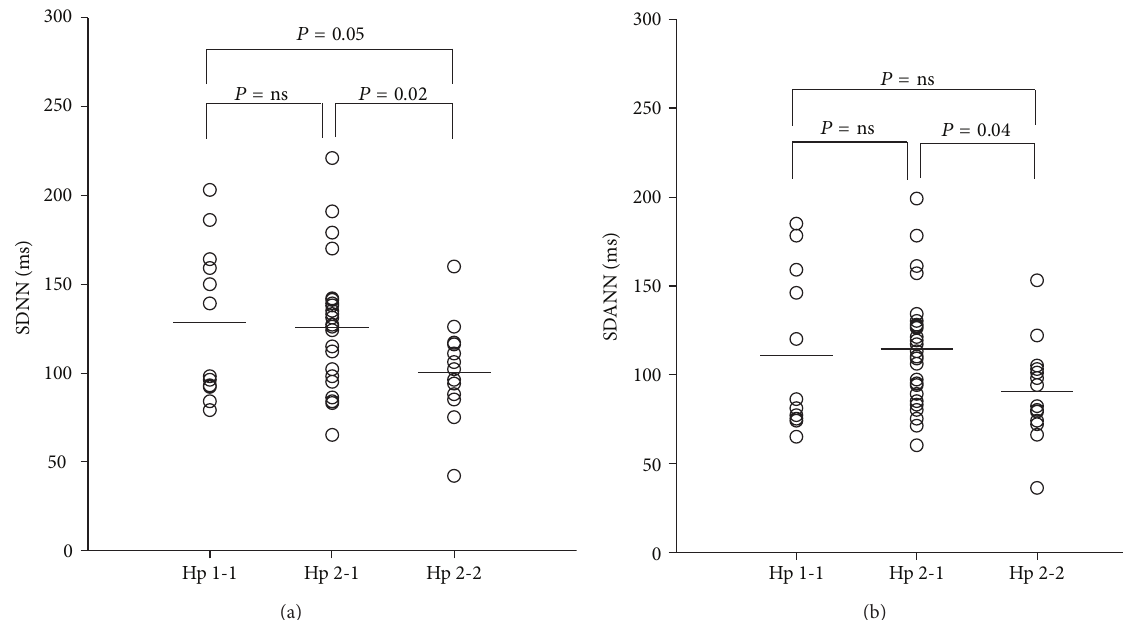
Figure 1: Dot plots showing (a) SDNN (ms) and (b) SDANN (ms) in haptoglobin genotypes 1-1, 2-1, and 2-2, respectively. The lines represent mean values. Abbreviations Hp: haptoglobin.